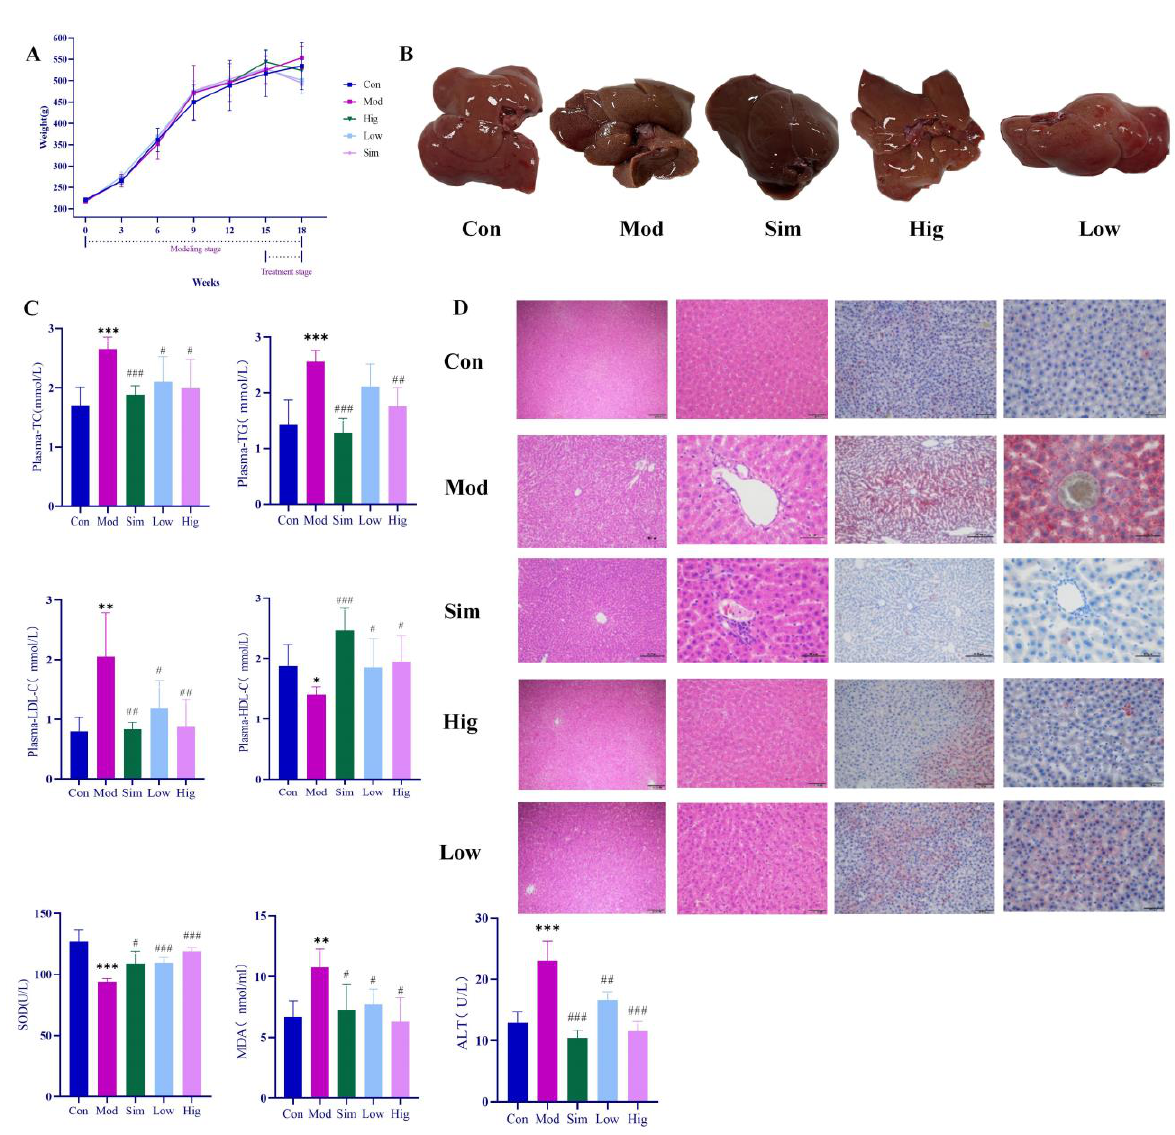
Figure 3. Results of anti-hyperlipidemia activity of genistin. Con: control group; Mod: high-fat diet group; Hig: genistin high dose treatment group; Low: genistin low dose treatment group; and Sim: simvastatin calcium administration group. ( A ) Statistics of body weight change in rats in test groups. ( B ) Rat liver photographs in test groups. ( C ) Hypolipidemic effect of genistin (TC, TG, LDL-C, HDL-C, ALT, SOD, and MDA levels in the plasma of rats). ( D ) The results of H&E staining (left, 100 μm and 400μm) and Oil Red O staining (right, 200 μm and 400 μm). n = 6. * p < 0.05, ** p < 0.01, and *** p < 0.001, Con vs Mod; and # p < 0.05, ## p < 0.01, and ### p < 0.00, Sim vs Mod, Hig vs Mod, Low vs Mod.